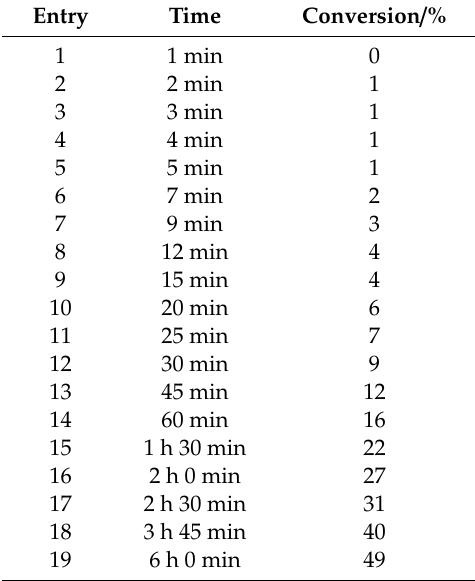
Table A6. Reduction of acetophenone ( 1 ) to 1-phenylethanol ( R )- 2 . Change from standard procedure: diethyl carbonate